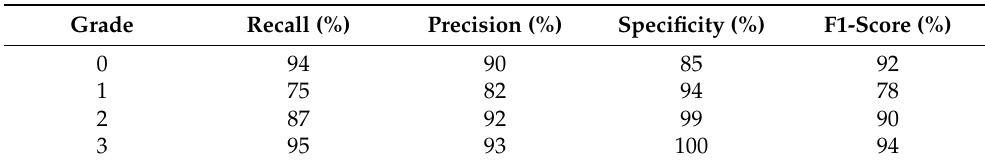
Table 5. The obtained experimental results when the proposed DHL-II is implemented on the unseen dataset of four classes.